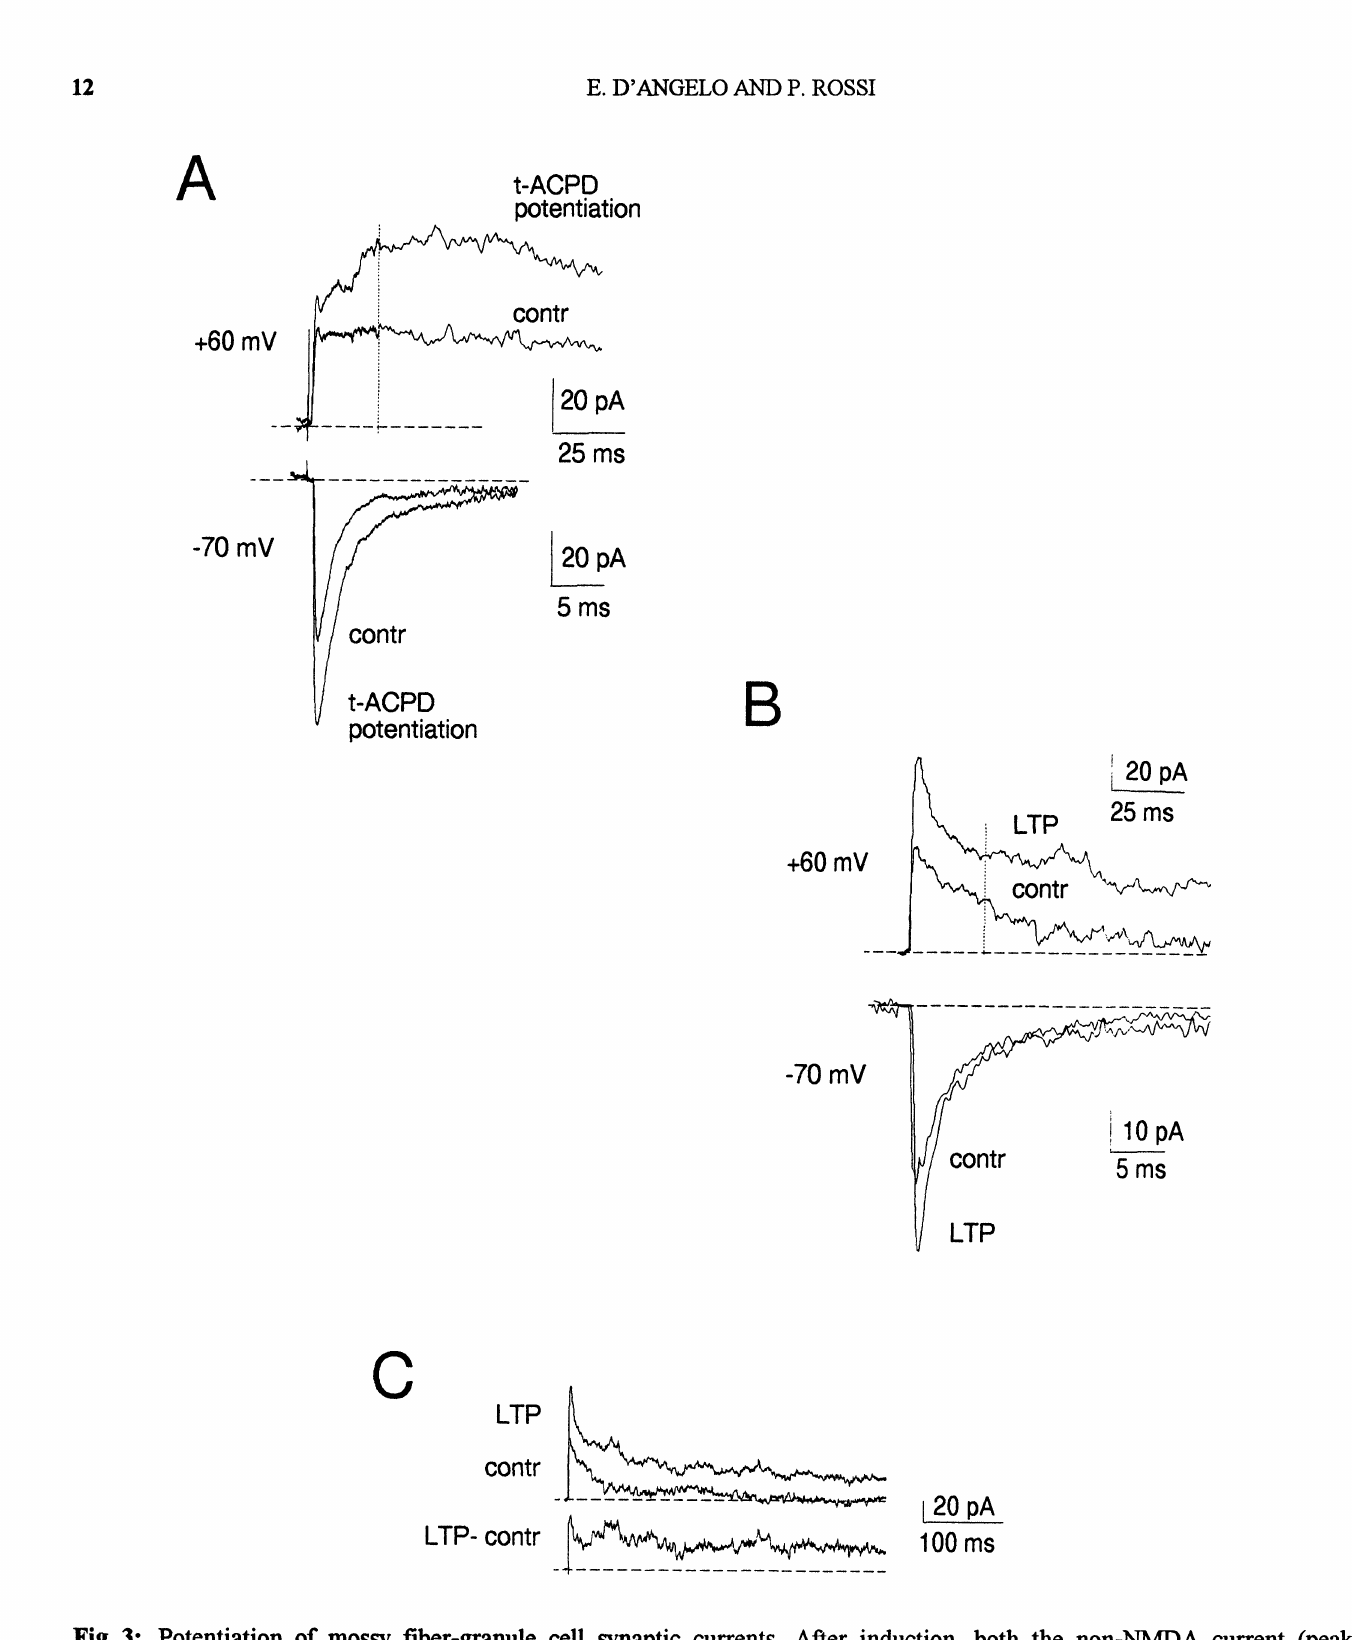
Fig. 3: Potentiation of mossy fiber-granule cell synaptic currents. After induction, both the non-NMDA current (peak amplitude at-70 mV) and the NMDA current (dotted line at +60 mV) were increased. Potentiation was induce by (A) low-frequency NMDA receptor synaptic activation (0.1 Hz) paired with a 60-see application of the metabotropic glutamate receptor agonist 20 glVl t-ACPD, or by 03) high-frequency NMDA receptor synaptic activation (8 bursts of 10 impulses at 100 Hz every 250 ms) paired with membrane depolarization to -40 mV. (C) Subtraction of control from potentiated tracings at +60 mV showed that the NMDA current increased in a slow component (same cell as in B). Data in A obtained from Rossi et al.,